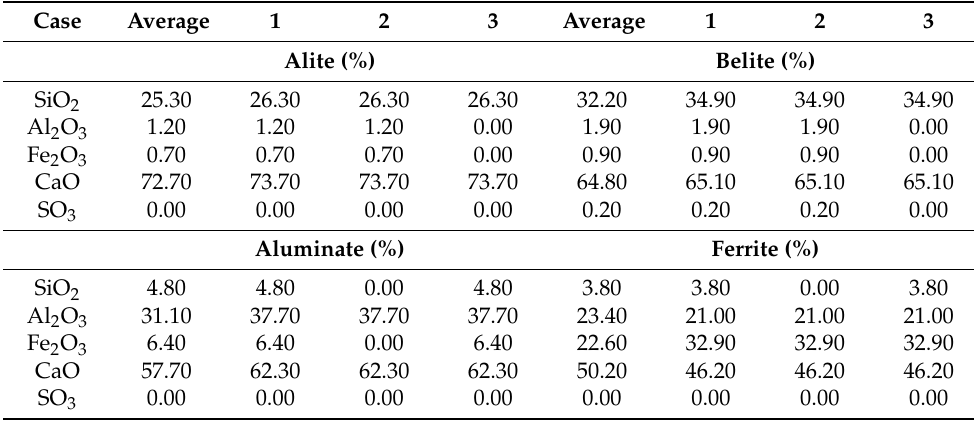
Table 9. Four chemical compositions of the cement compounds proposed in this